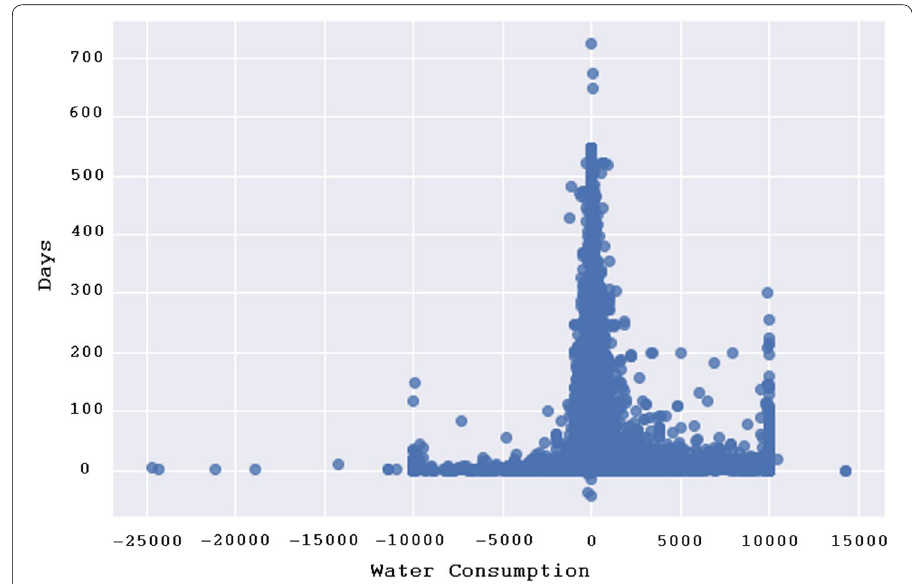
Fig. 2 Time intervals vs differential water consumption (two consecutive